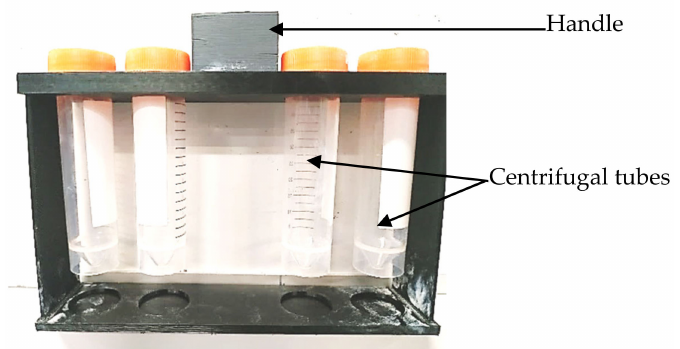
Figure 1. Custom-built tray used in Experiment 1 for moving centrifugal